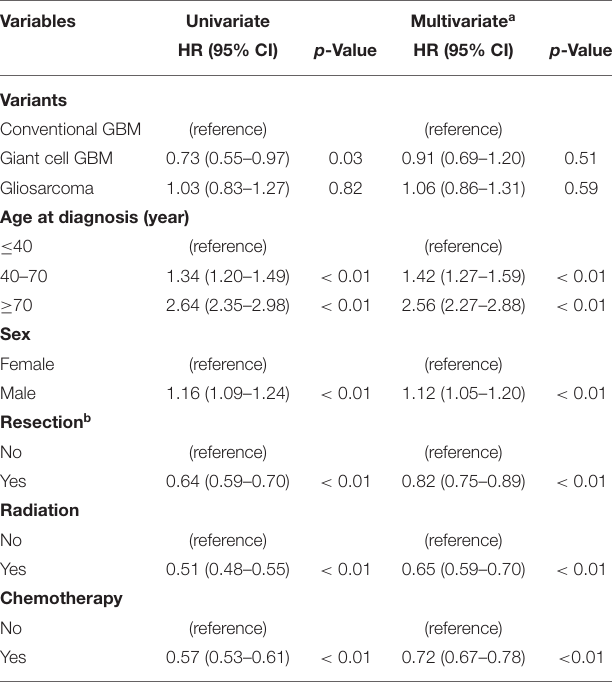
TABLE 2 | Univariate and multivariate Cox regression analyses of potential factors associated the survival of overall glioblastoms cohort.